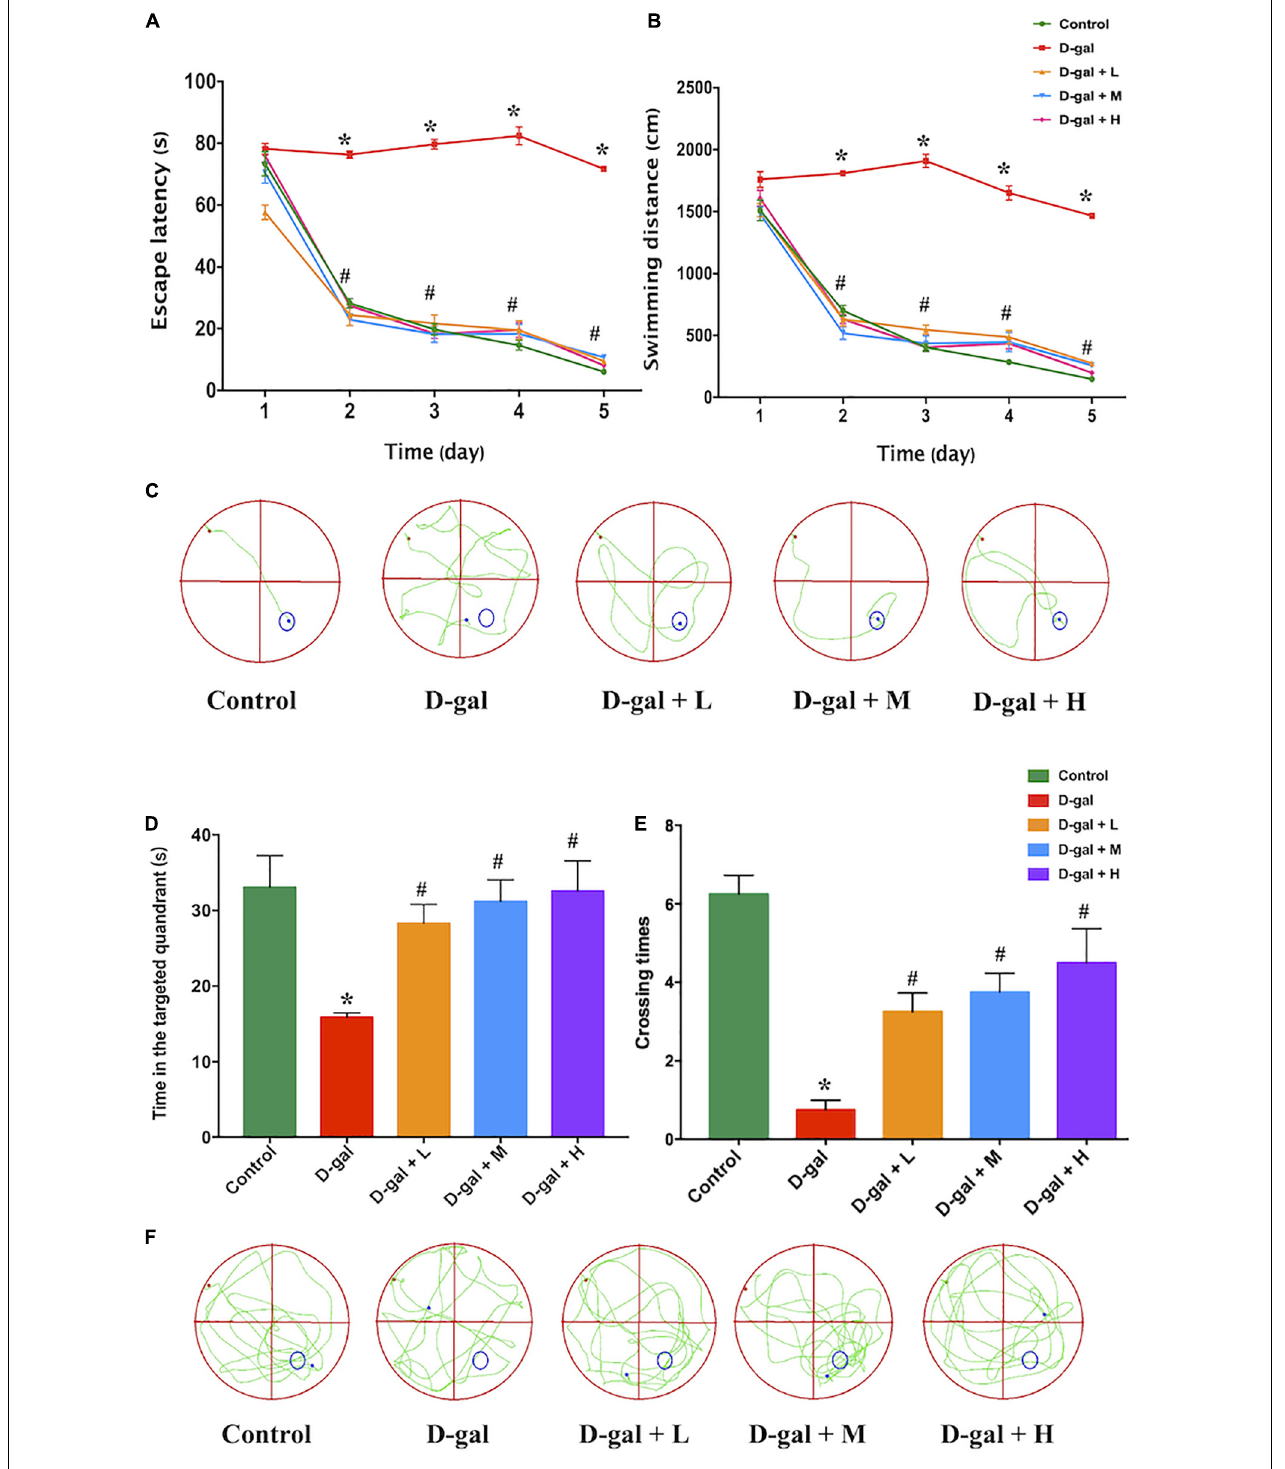
FIGURE 3 | Effects of the dietary supplement on learning and memory impairment in Morris water maze test ( n = 4 in each group). The escape latencies (A) , swimming distance (B) , the typical swimming path on the fifth day (C) in the navigation training, the time in the targeted quadrant (D) , platform crossing times (E) , and the typical swimming path (F) in the probe trial. Values are presented as means ± SEM. * p < 0.05 when compared with the control group; # p < 0.05 when compared with the D-gal group. D-gal, D-galactose; SEM, standard error of mean.